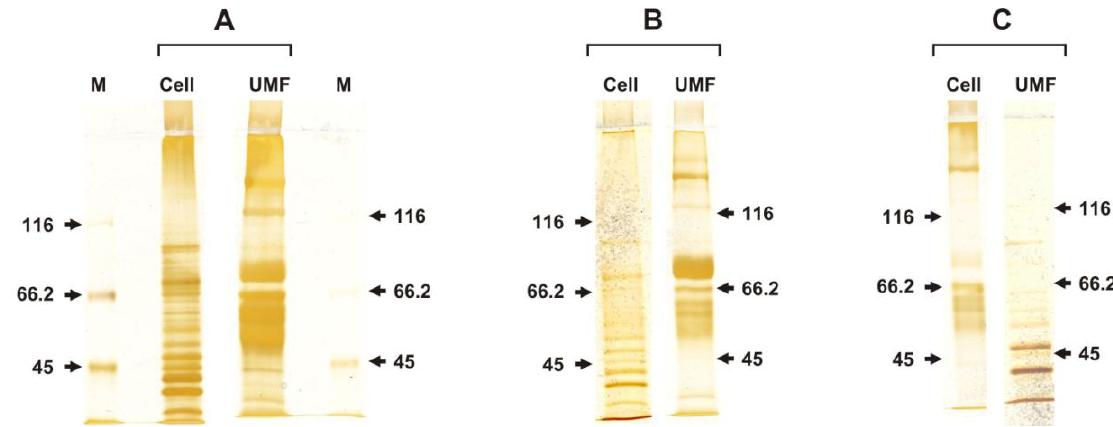
FIGURE 6. SDS-PAGE of proteins A. laidlawii PG8 cells and ultramicroforms (UMF) derived from lysates of whole cells (A), membrane (B), and cytoplasm. M = marker of molecular mass